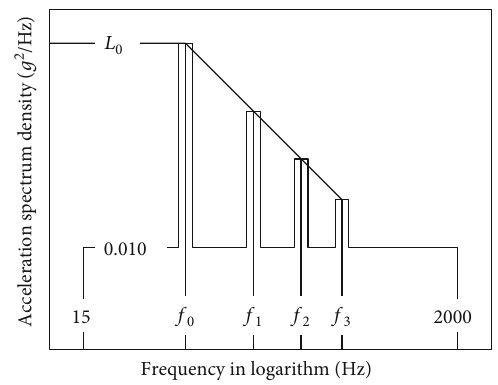
Figure 10: Vibration power spectral density.